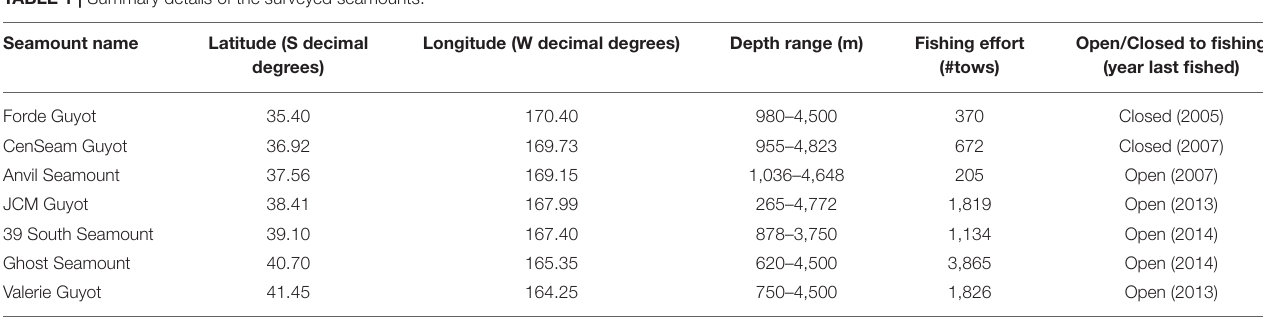
TABLE 1 | Summary details of the surveyed